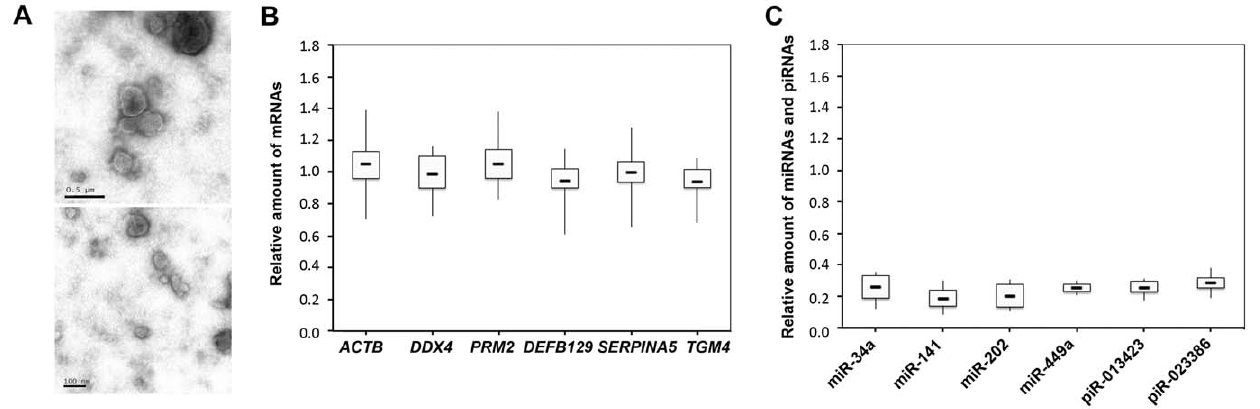
Figure 2. Characterization of SMVs and the proportions of cfs-mRNAs and cfs-miRNAs in SMVs. SMVs (A) were approximately 30 nm- 0.5 m m in diameter using a transmission electron microscope. The amount of mRNAs (B, n=16) and miRNAs (C, n=6) in the SMVs was normalized to the amount in the seminal plasma. Horizontal lines within the boxes denote the median. The boxes and whiskers represent intervals between the 25th to 75th percentiles, and the 2.5th to 97.5th percentiles, respectively.